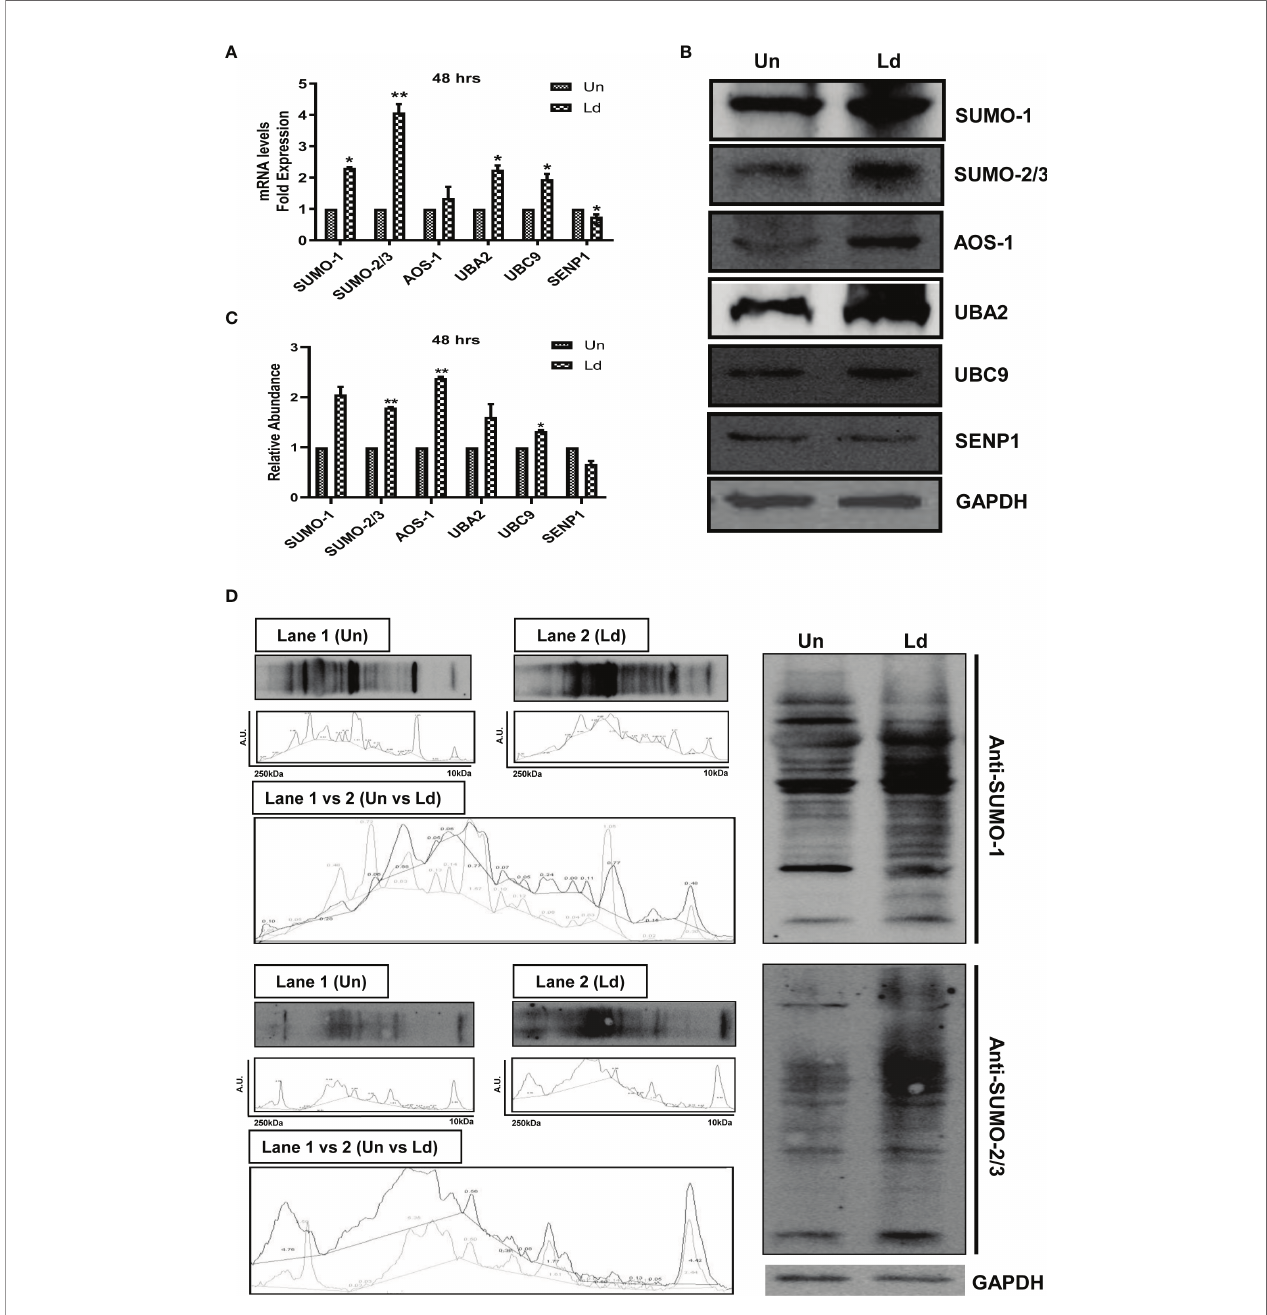
FIGURE 1 | Induced expression of genes involved in host SUMOylation pathway upon Leishmania donovani infection. PMA-differentiated THP-1 macrophages were infected with metacyclic stage L. donovani promastigotes at 20 MOI for 48 (h) Uninfected (Un) and L. donovani -infected (Ld) cells were processed for different evaluations. (A) RNA was isolated from uninfected and infected macrophages at 48 h post-infection, and expression analysis of genes of the host SUMOylation pathway was performed by quantitative real-time PCR (qRT-PCR). p -Value was calculated based on Student ’ s unpaired 2-tailed t-test comparing uninfected macrophages to infected macrophages (* p < 0.05 and ** p < 0.01). (B) Cytoplasmic extracts of uninfected and infected macrophages were analyzed by Western blotting to check the expression level of SUMO-1, SUMO-2/3, AOS-1, UBA2, UBC9, and SENP1 at 48 h post-infection. GAPDH was used as the loading control. Band intensities were calculated using ImageJ software. Data from one of three experiments are shown. (C) The graph represents the relative intensity of the bands calculated by ImageJ software at 48 h post-infection; * p = 0.028 for UBC9; ** p = 0.0043 and 0.0073 for SUMO-2/3 and AOS-1, respectively. p -Value was calculated based on an unpaired t-test with Welch ’ s correction comparing uninfected macrophages to L. donovani -infected macrophages (Un vs. LD). (D) Cytoplasmic extracts of uninfected and infected macrophages were analyzed by Western blotting to check the expression of overall SUMOylated proteins at 48 h post-infection. GAPDH was used as the loading control. The band intensities of each lane were analyzed by ImageJ software, and the values concerning band intensity are labeled on the peaks. PMA, phorbol 12-myristate 13-acetate; MOI, multiplicity of